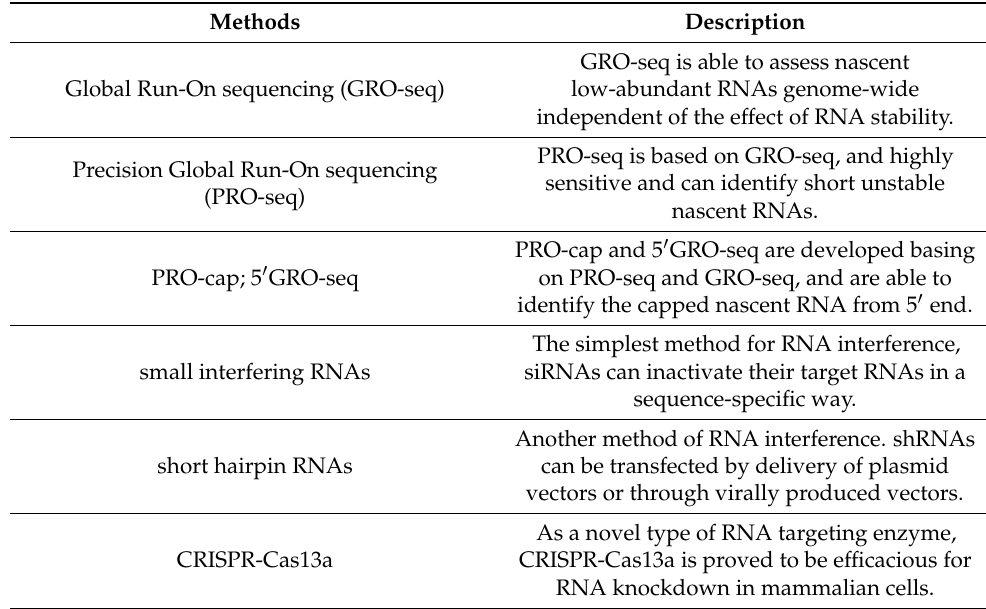
Table 2. Methods for identification and functional investigations of